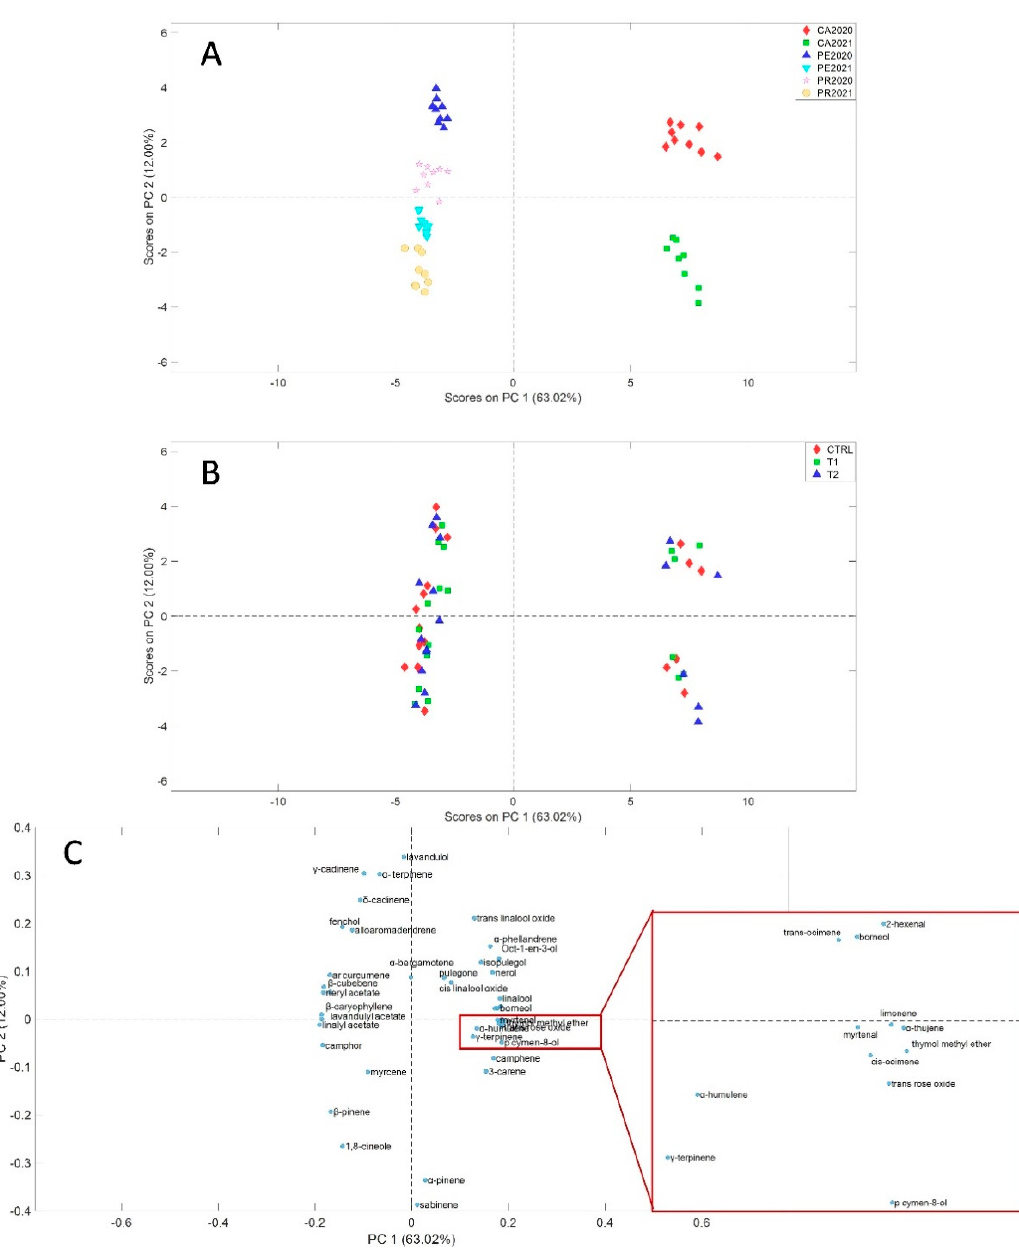
Figure 5. Principal component analysis (PCA) biplot for the chemical composition of EOs from 2019/2020 and 2020/2021. Score plots labelling the farms ( A ) and the treatments ( B ); ( C ) loading plot. CA, Campazzo; PE, Pedroni; PR, Preci; CTRL, control with foliar application of tap water; T1, foliar application of FITOSTIM; T2, foliar application of FITOSTIM ALGA.